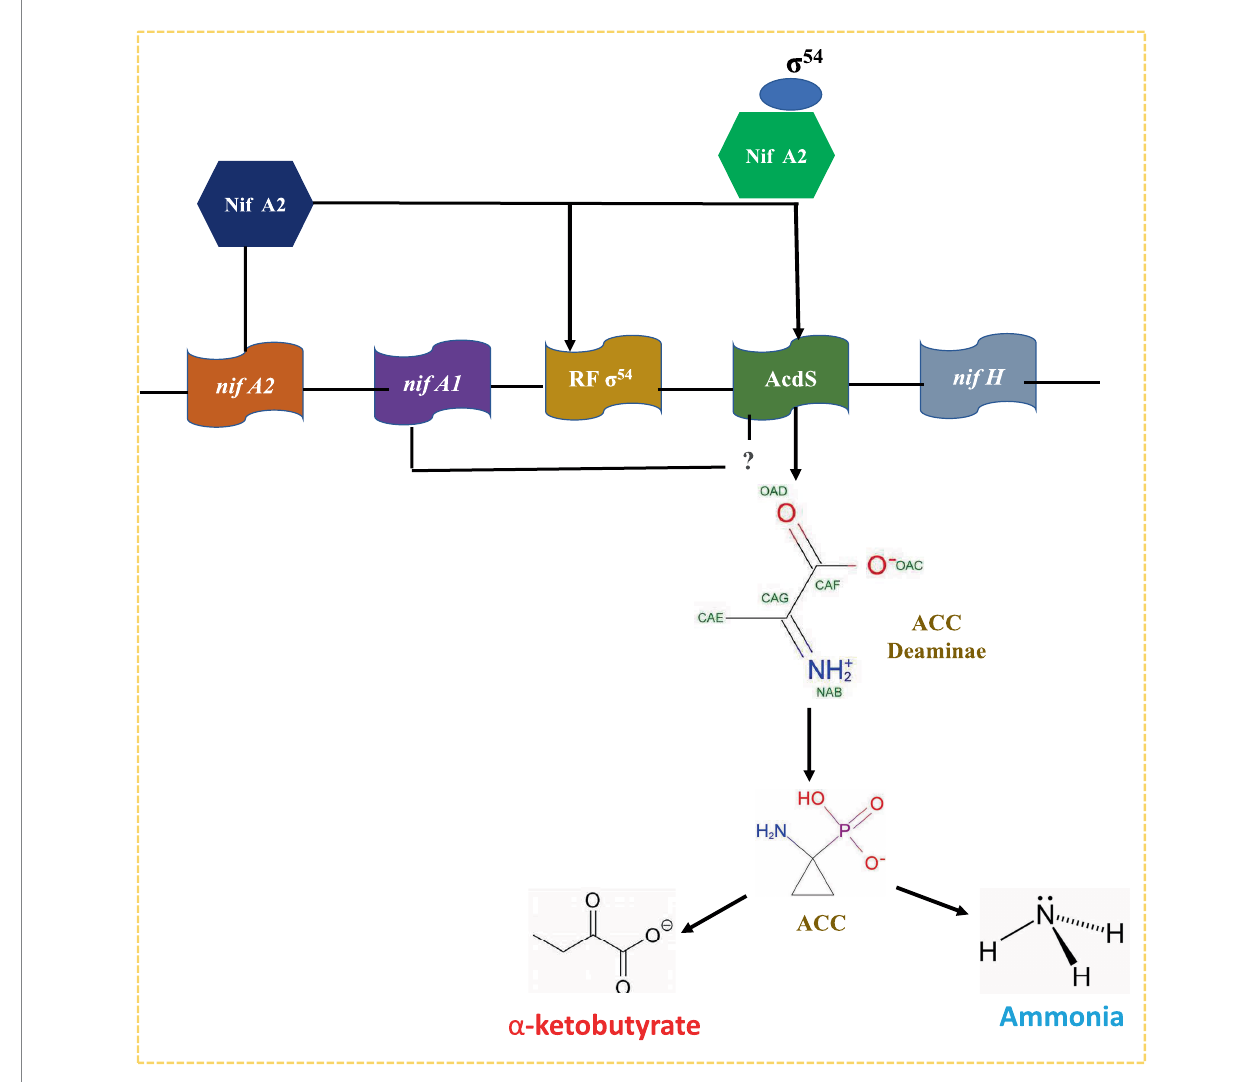
FIGURE 3 A model for acds gene regulation in nitrogen fixing Mesorhizobium sp. Expression of acds is positively regulated by NIFA 2 protein which binds to σ 54 and switch on transcription of AcdS gene. Nifa 1 is also required in regulation of AcdS but its role is not